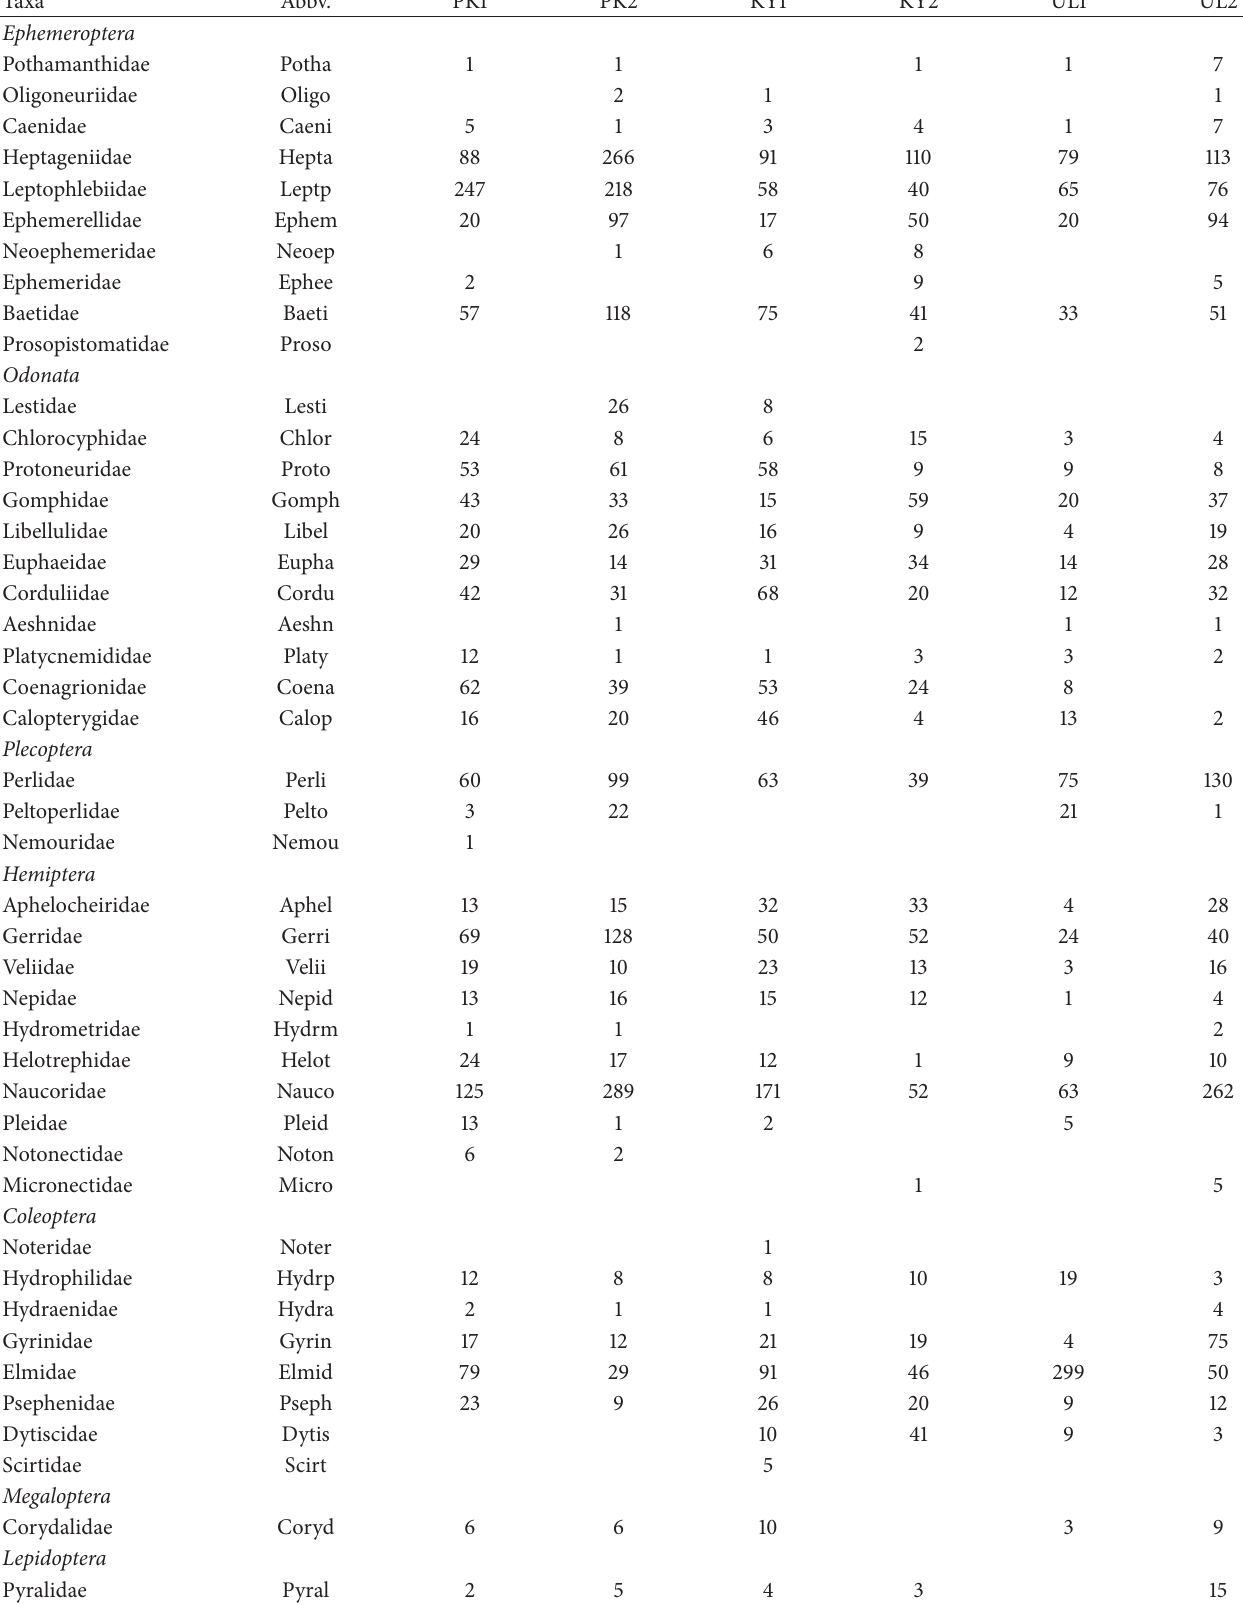
Table 1: The composition and total abundance of aquatic insect communities in Mae Klong